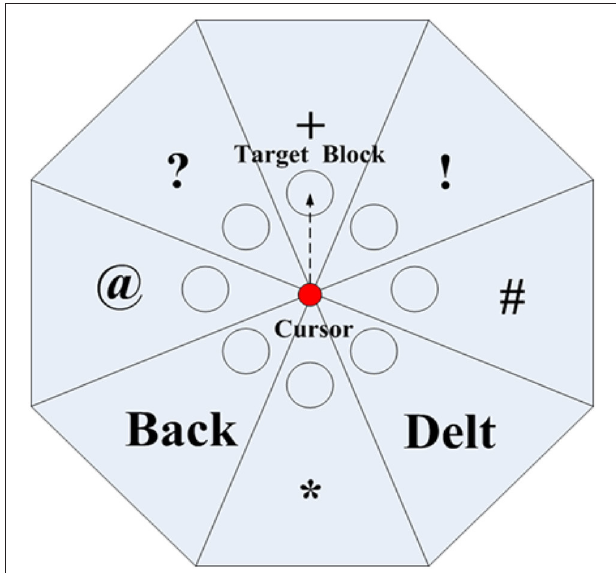
FIGURE 4 | The user performs MI tasks to drive the cursor to the circle of the target block. The corresponding character will be selected for output.